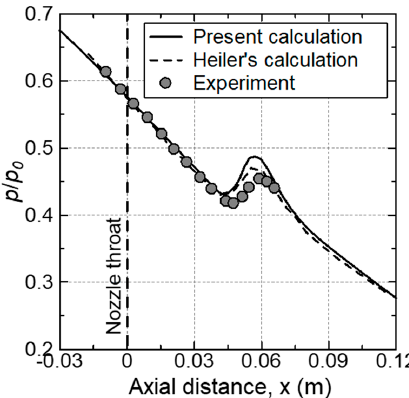
Figure 2. Distribution of static pressures along the axis of a Barschdorff nozzle.